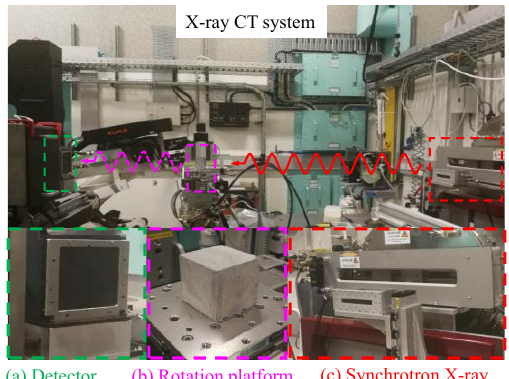
Fig. 3. Synchrotron X-ray computed tomography (CT)